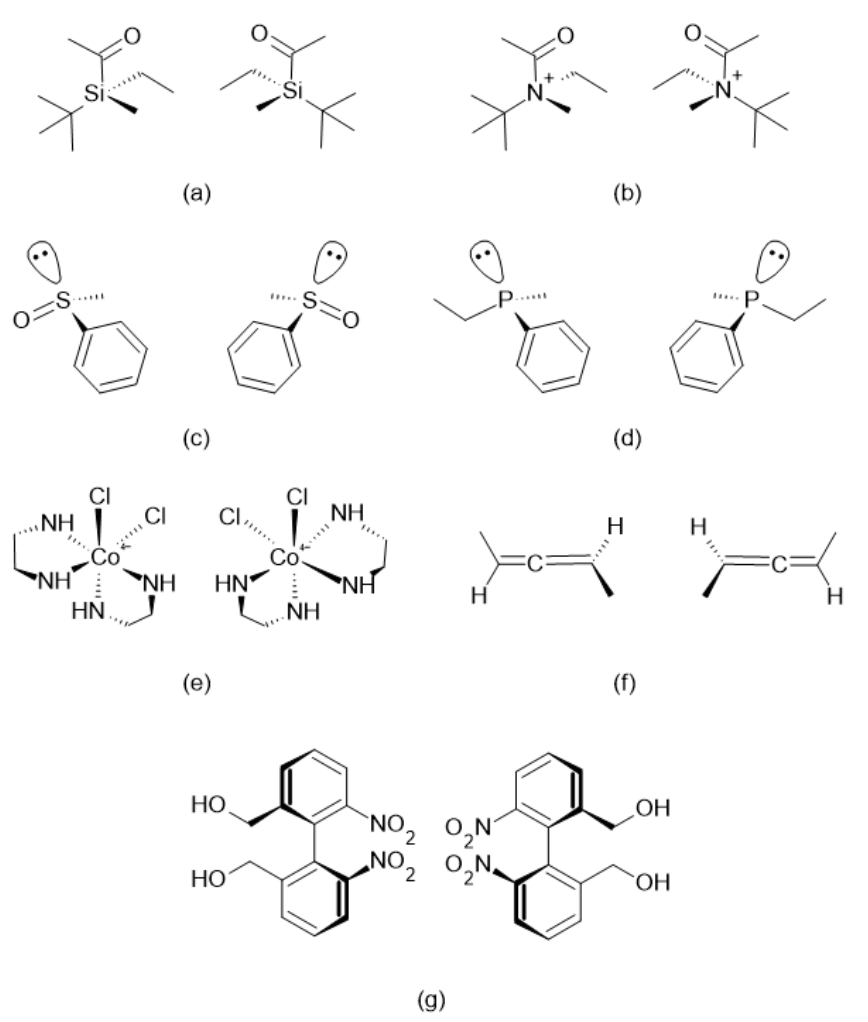
Figure 2. Pairs of enantiomers of ( a ) chiral silicon, ( b ) chiral nitrogen, ( c ) chiral sulfur, ( d ) chiral phosphorus, ( e ) cobalt complex, ( f ) allenes and ( g ) atropisomers.